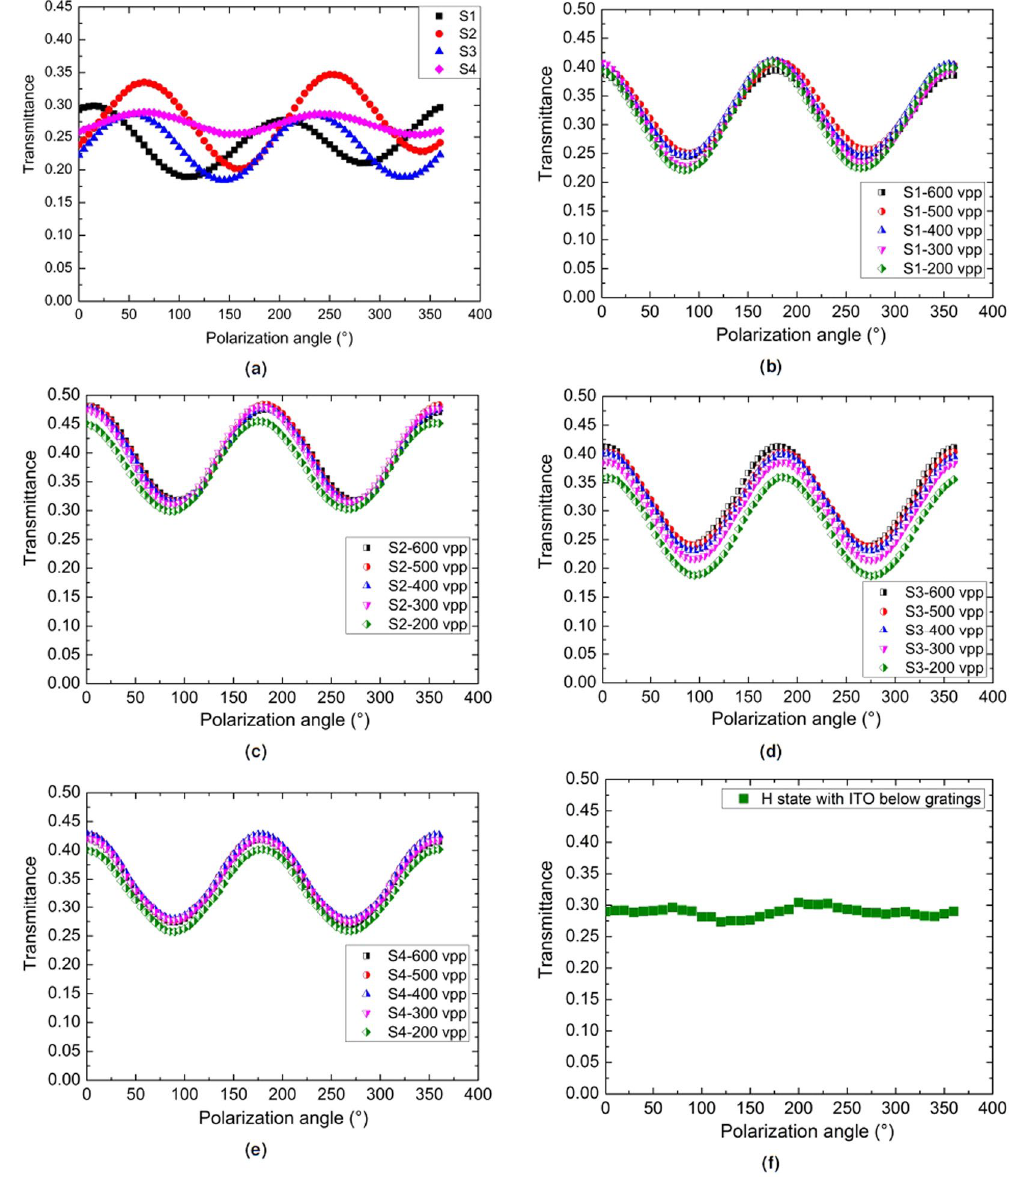
Figure 5. Transmission versus polarizing angle of the DF-Ch-LC beam deflectors in different states: ( a ) different schemes in P states; ( b ) H states of Scheme 1; ( c ) H states of Scheme 2; ( d ) H states of Scheme 3; ( e ) H states of Scheme 4; ( f ) H state of DF-Ch-LC grating devices with the ITO layer below micro gratings by applying V app = 600 V pp